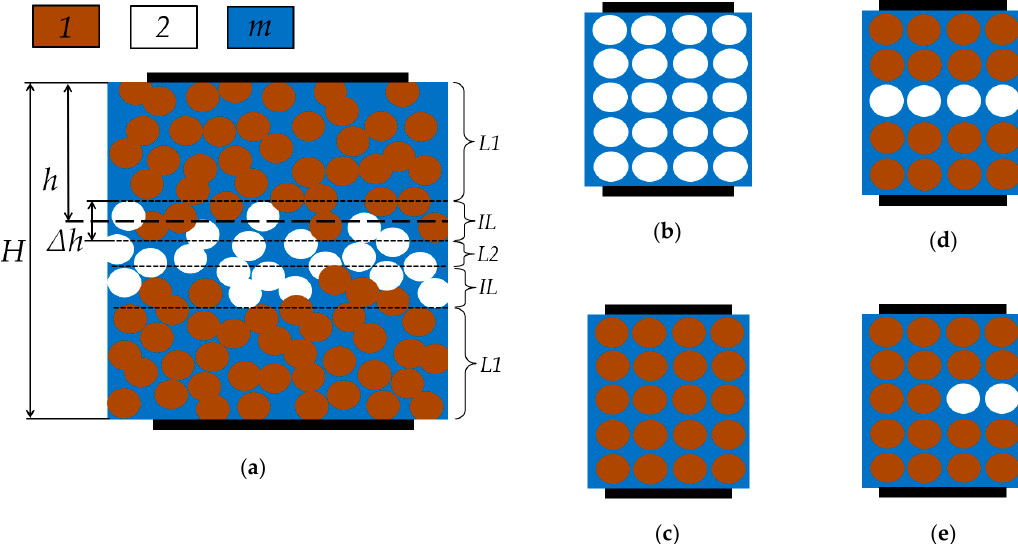
Figure 9. The composite film model ( a ) and its simplified particular cases: only porous matrix ( b ); all pores are filled ( c ); a model where the intermediate layer can be neglected ( d ); a model where the central layer is particularly filled ( e ), where 1 is ferroelectric, 2 is air, m is medium matrix.